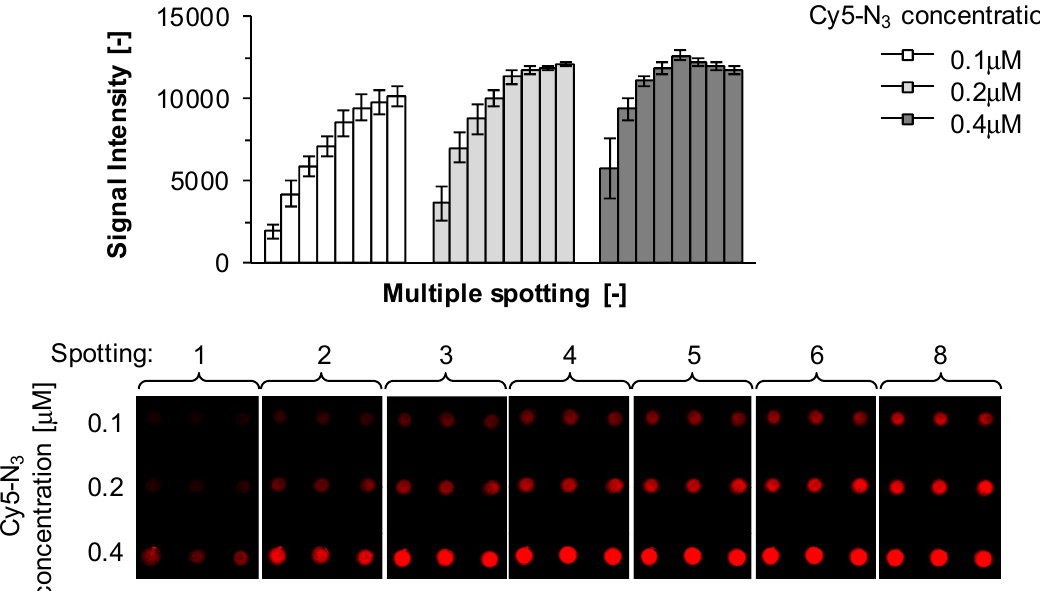
Figure 2. Characterization of slide reactivity. Fluorescence signal intensity at λ = 635 nm recorded on ADIBO-activated glass slides after sequential spotting (8 times) of 2 μ L of in 25% DMSO/H O at three different concentrations (0.1, 0.2 and 0.4 μ M, Cy5-N 3 2 respectively) and corresponding wash cycles ( top ). A microarray image is shown from one representative experiment ( bottom ). Data are mean values ± SD of triplicate